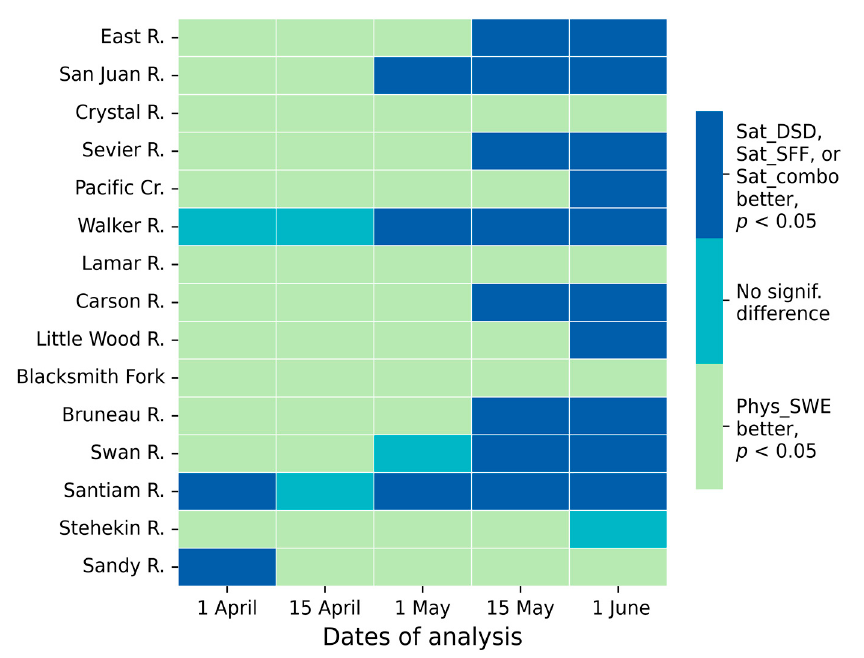
Figure 8. A comparison of model skill among satellite and in-situ-based models over time. The satellite model with lowest median PBIAS at a given date was selected for comparison with the Phys_SWE model.